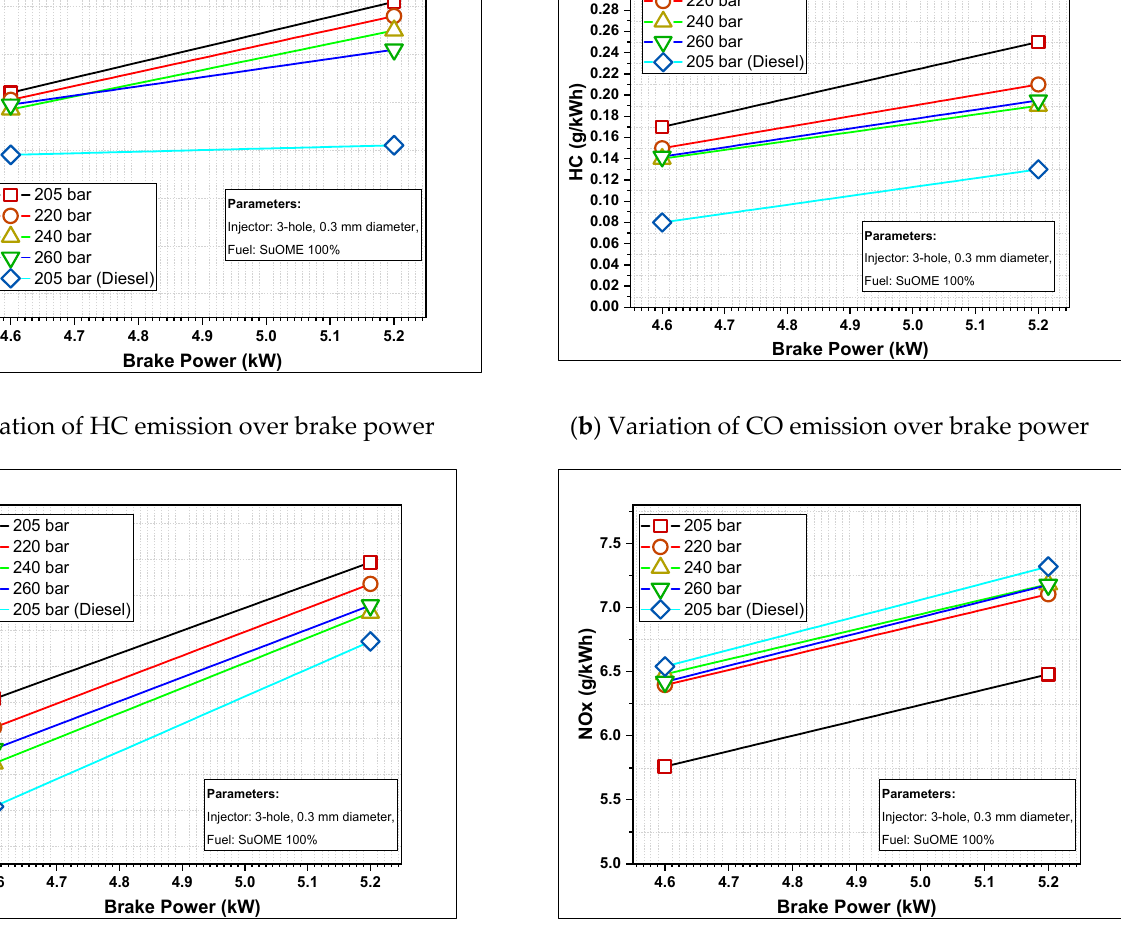
Figure 4. Variations of ( a ) HC, ( b ) CO, ( c ) smoke and ( d ) NO x at different brake